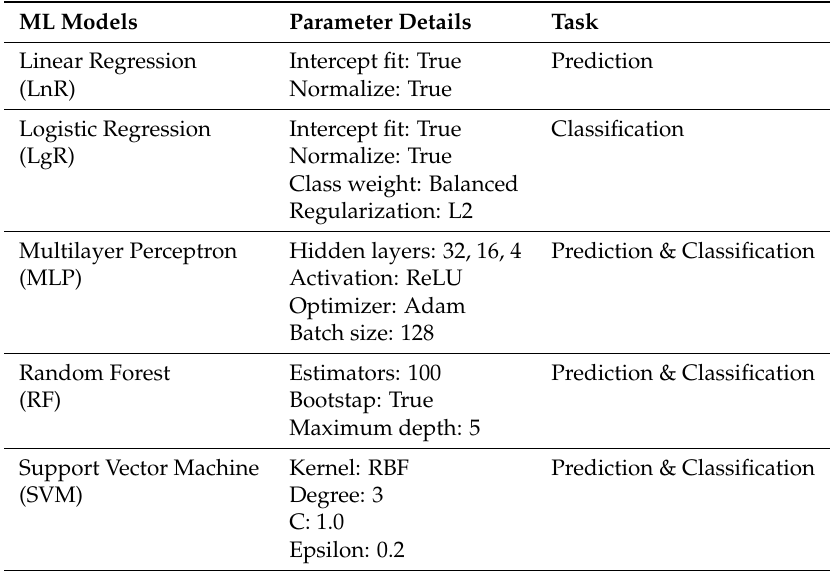
Table 3. Parameters used in building different models for prediction and classification